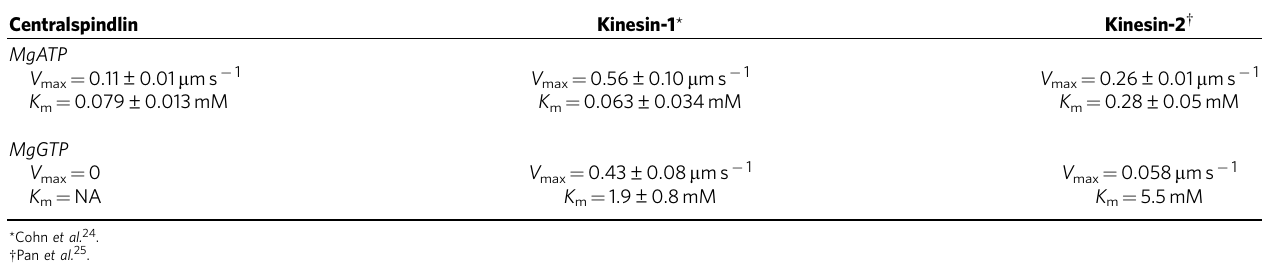
Table 3 | Comparison of the kinetic parameters between centralspindlin and other kinesins. Centralspindlin